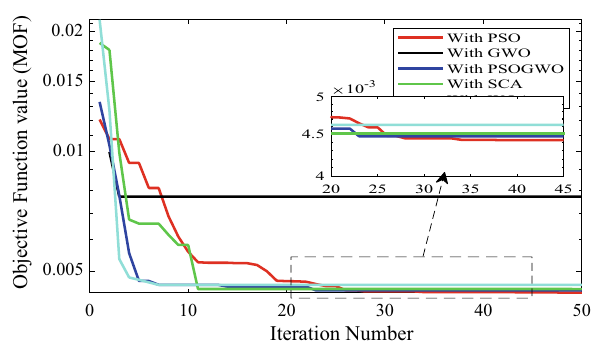
Figure 13. Convergence curve for 4-DG integration with different